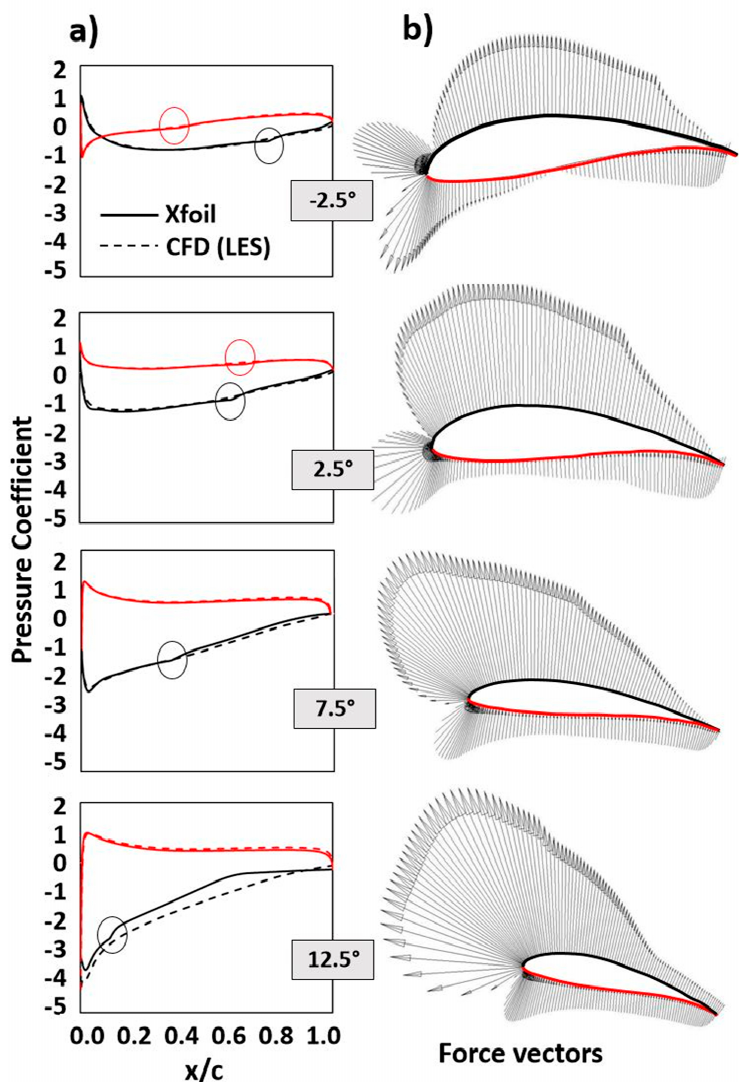
Figure 12. ( a ) Pressure coefficient for different angles of attack. ( b ) Pressure vectors on the airfoil.